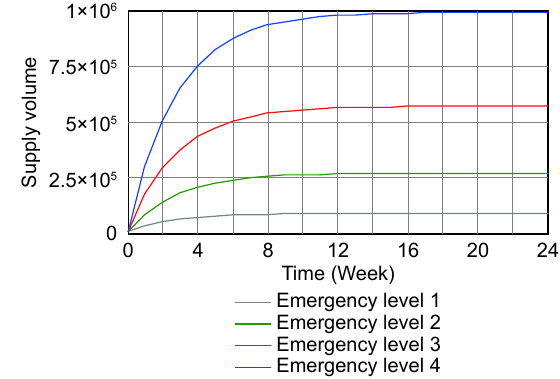
Fig. 7 Deviation of material supply and demand under different emergency degrees. 11th, and 13th weeks, respectively.